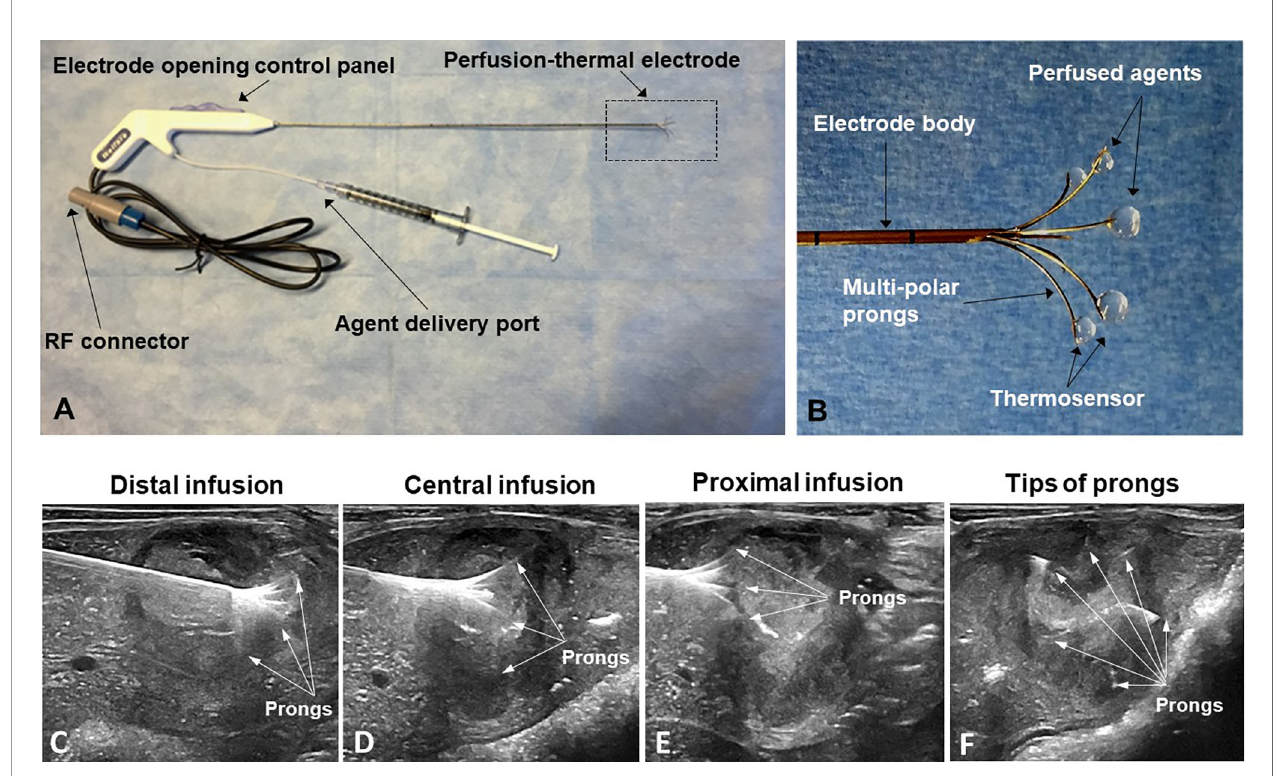
FIGURE 3 | (A, B) The multimodal perfusion thermal electrode with multipolar agent infusion prongs. Micro-thermosensors are equipped at the tips of the prongs for real-time measurement of peritumoral RFH at approximately 42°C, while the central-tumoral RFA tempreature from the electrode body was pre-set at approximately 80°C. (C – F) The stepwise peri-tumor delivery of doxorubicin under real-time ultrasound guidance. The perfusion-thermal electrode is advanced, sequentially into the portion of the tumor most distal from the entry site. At regular intervals during electrode advancement through the tumor, the electrode prongs are opened to the desired size array, with the objective of completely enveloping the tumor peripheral zone for suf fi cient delivery of the chemotherapeutic agent. During delivery of the chemotherapeutic agent, RFA-mediated RFH at the tumor margin is generated with the same device to further enhance chemo-destruction of tissues at the tumor margins. (A – C) Longitudinal sonographic images; (D) Transverse